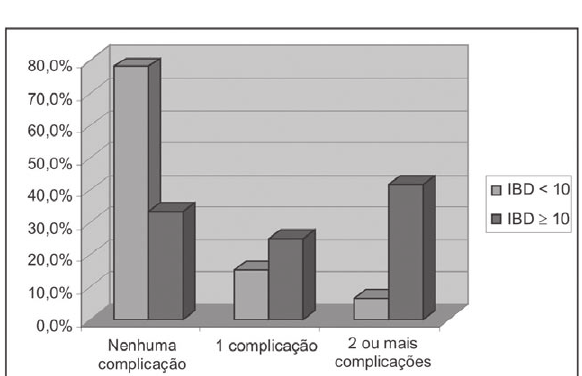
Fig. 1 - Escore no Inventário Beck de Depressão na fase I e número de complicações no pós-operatório tardio (p=0,003)